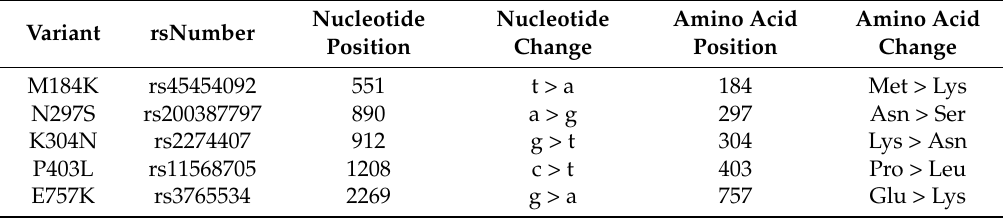
Table 1. Summary of the non-synonymous SNPs in ABCC4 selected in the present study.